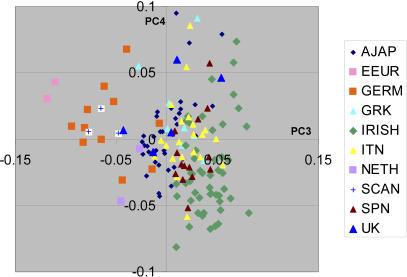
Graphic Display of Principal Components 3 and 4 after Deletion of Chromosome 8 InversionResults of individuals with 4GP information are shown.